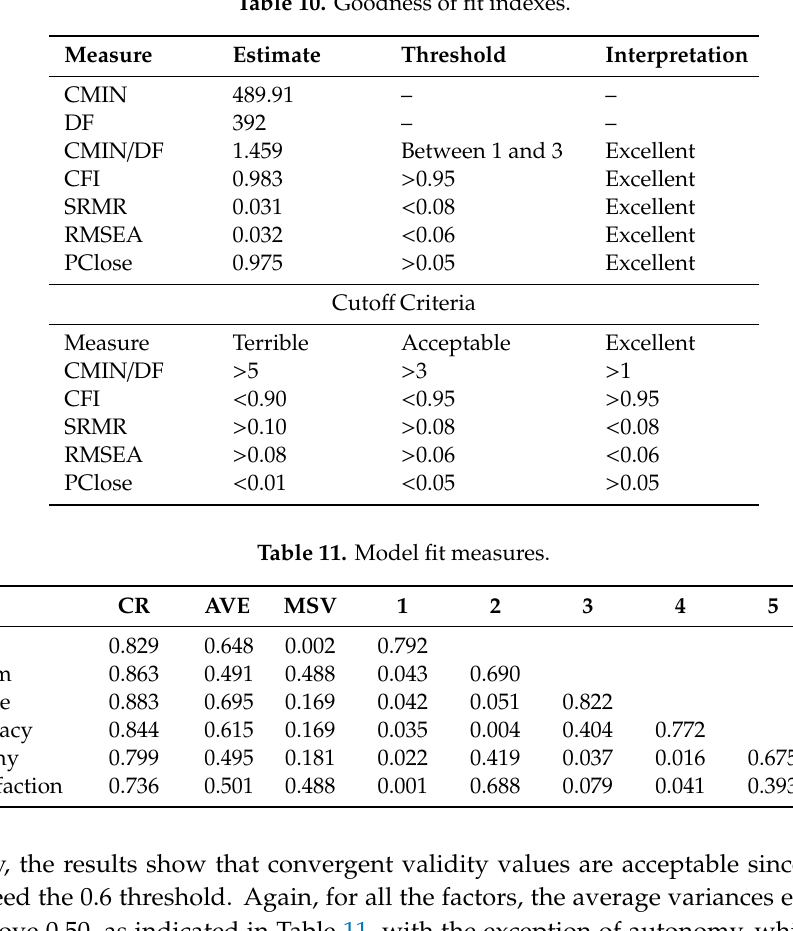
Table 10. Goodness of fit indexes.